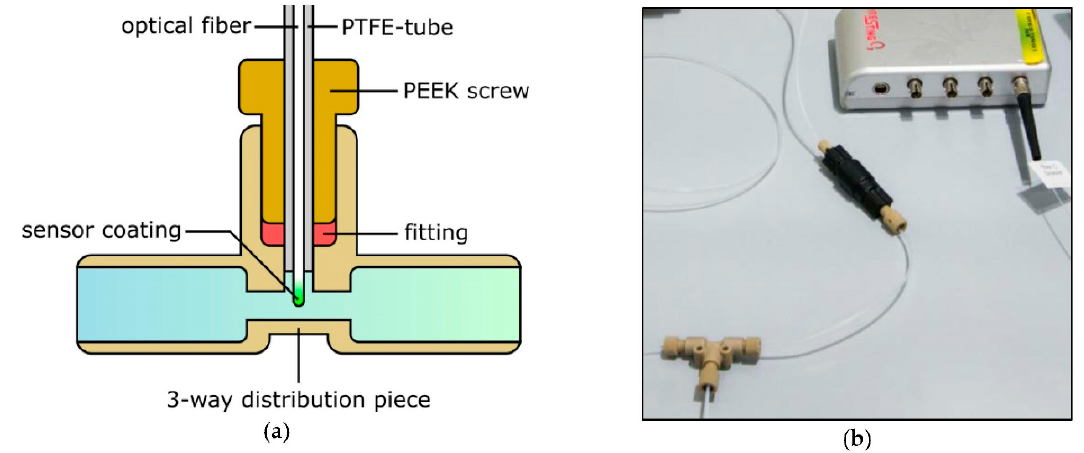
Figure 1. ( a ) Schematic visualization of the sensor implementation via standard HPLC equipment; ( b ) photograph of the sensor integrated into a continuous flow system. On the upper right corner the miniaturized phase fluorimeter used for readout can be seen.